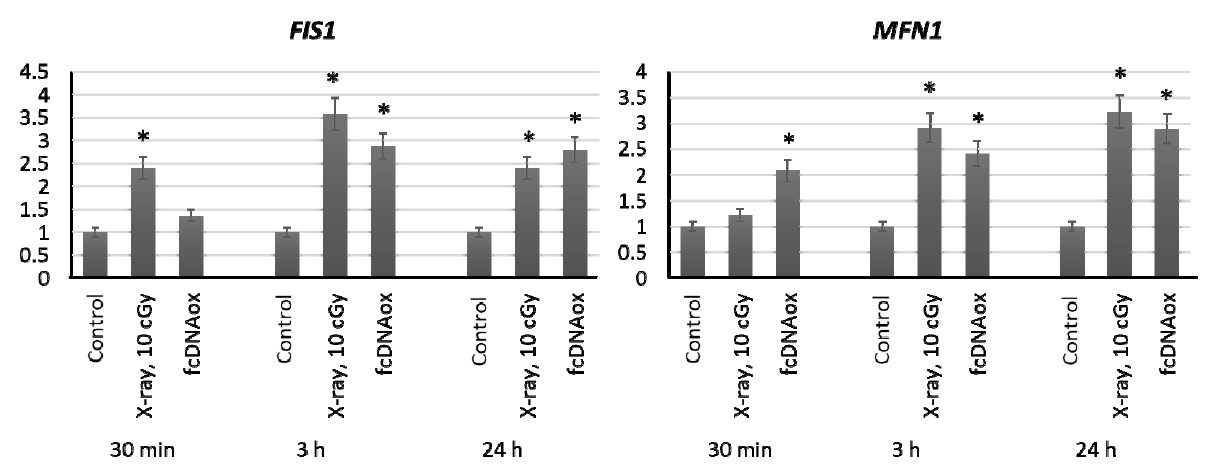
Figure 7. The expression of genes regulating fusion and division of mitochondria influenced by low-dose radiation (10 cGy) and oxidized cfDNA (50 ng/mL) assessed by real-time PCR. The genes are indicated in the figure. Ratios to control values are presented. The TBP gene was used as an internal standard gene. Mean values were calculated from five independent measurements; (*) denotes a significant difference from control experiments, p < 0.001, nonparametric U-test.